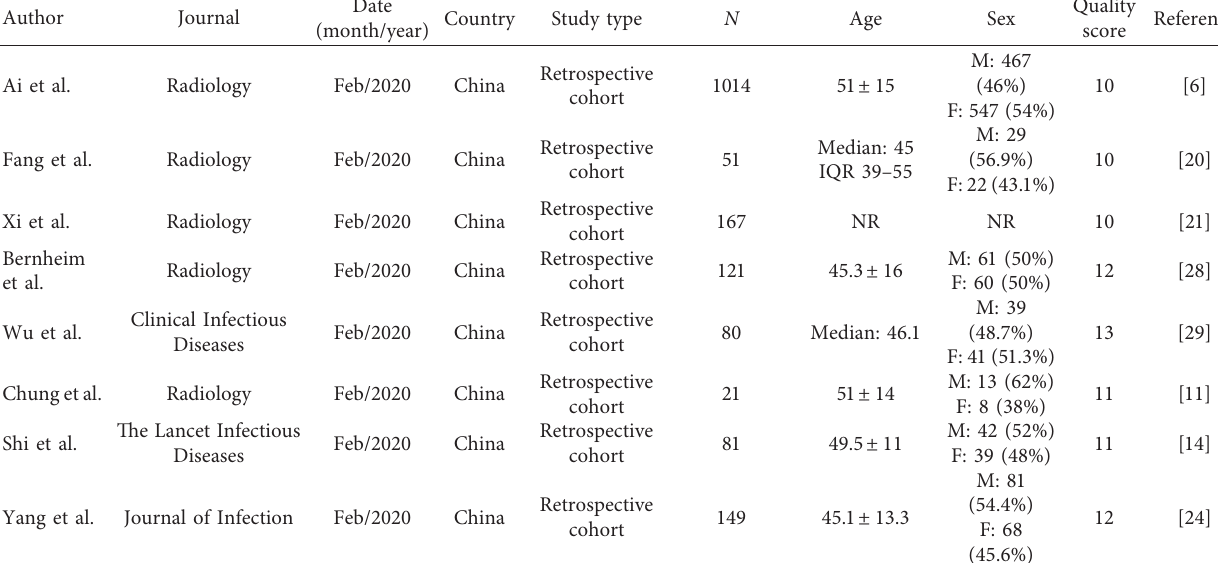
Figure 1: PRISMA flow chart for systematic review of studies identifying chest CT versus RT-PCR. Table 1: Characteristics of the included